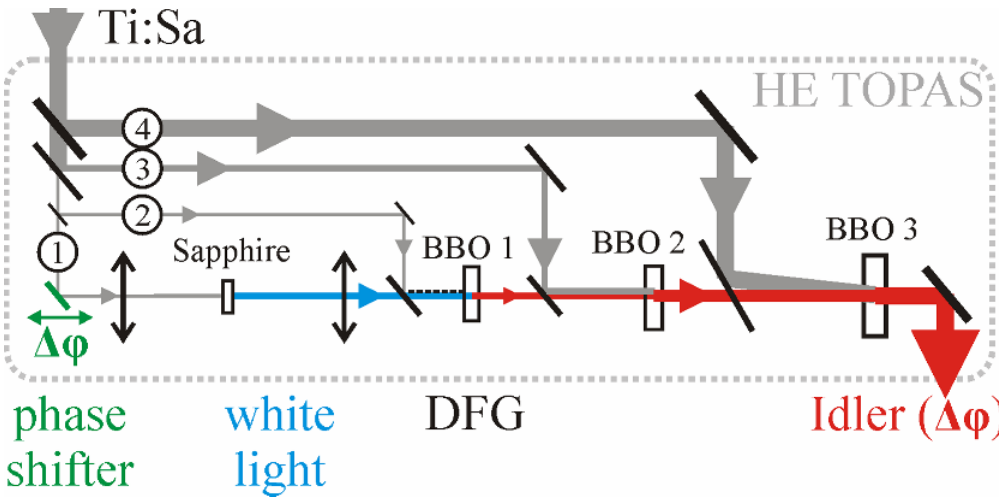
Fig. 1. Experimental setup for interferometrically CEP controlled high energy IR pulses based on passive CEP stabilization via difference frequency generation (DFG). The phase shift ( ∆φ ) of the 800 nm beam in arm 1 is preserved during self-phase modulation in the Sapphire window. This phase shift is transferred to the Idler in the DFG process and maintained in the subsequent amplification